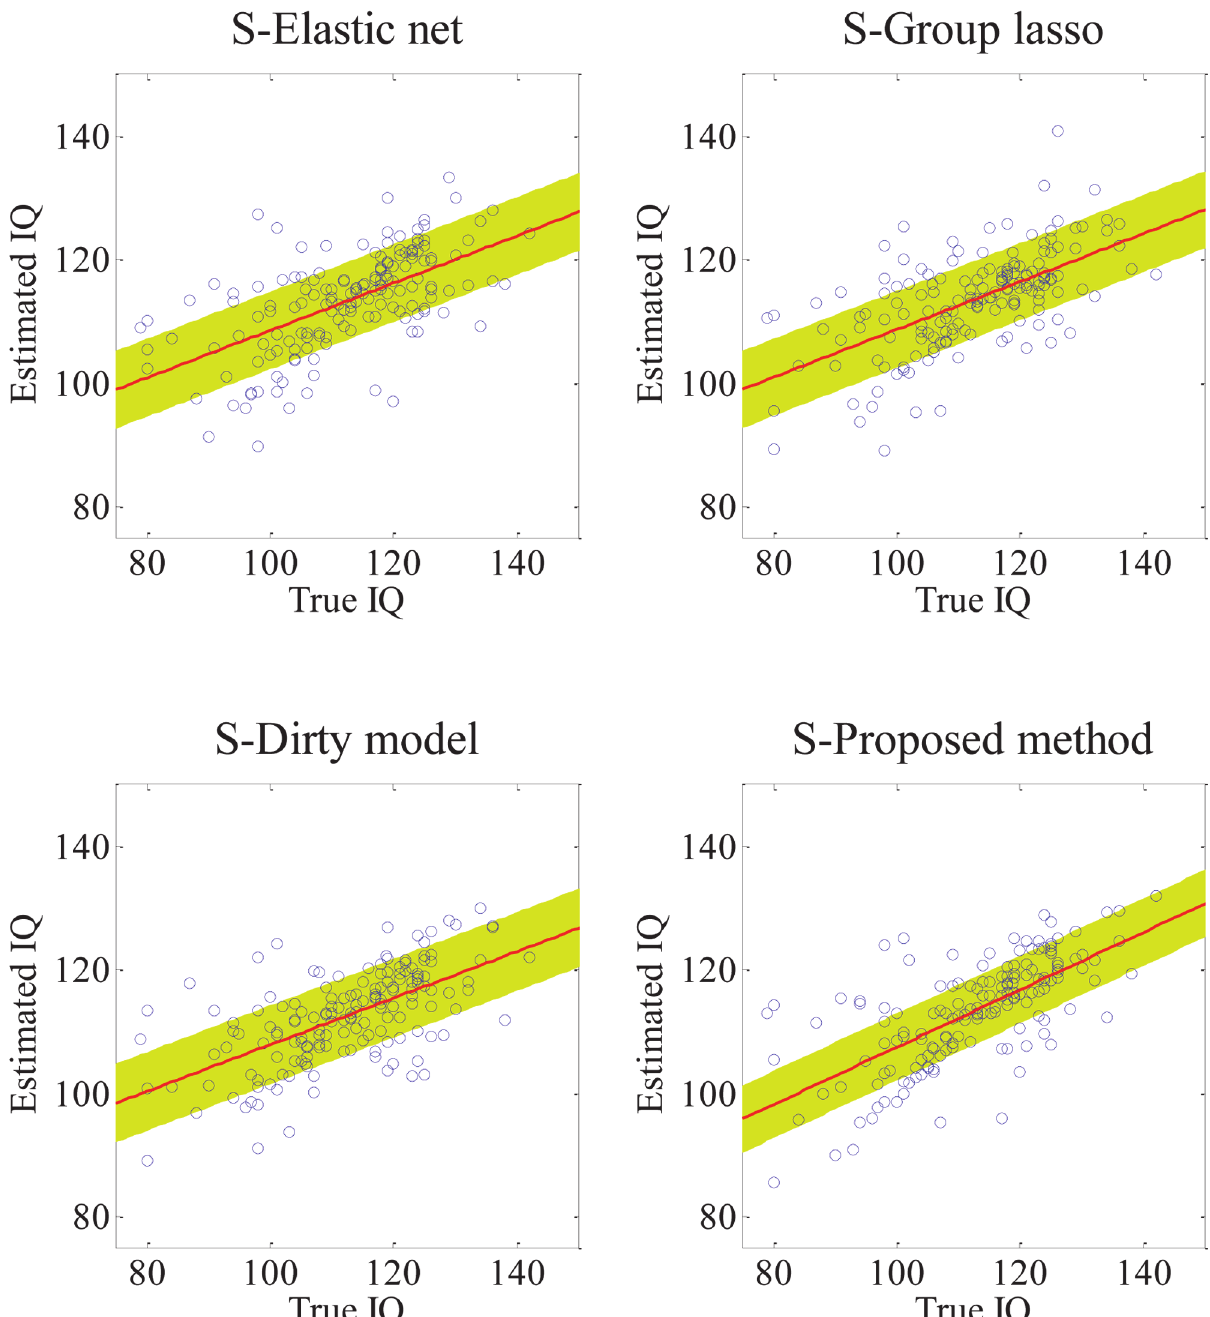
Fig 6. Scatter plots of the true IQ vs. the estimated IQ by single-kernel SVR. Scatter plots of the true IQ vs. the estimated IQ by the four competing methods with a single-kernel SVR, along with the standard deviation of the distance for each point to the fitted